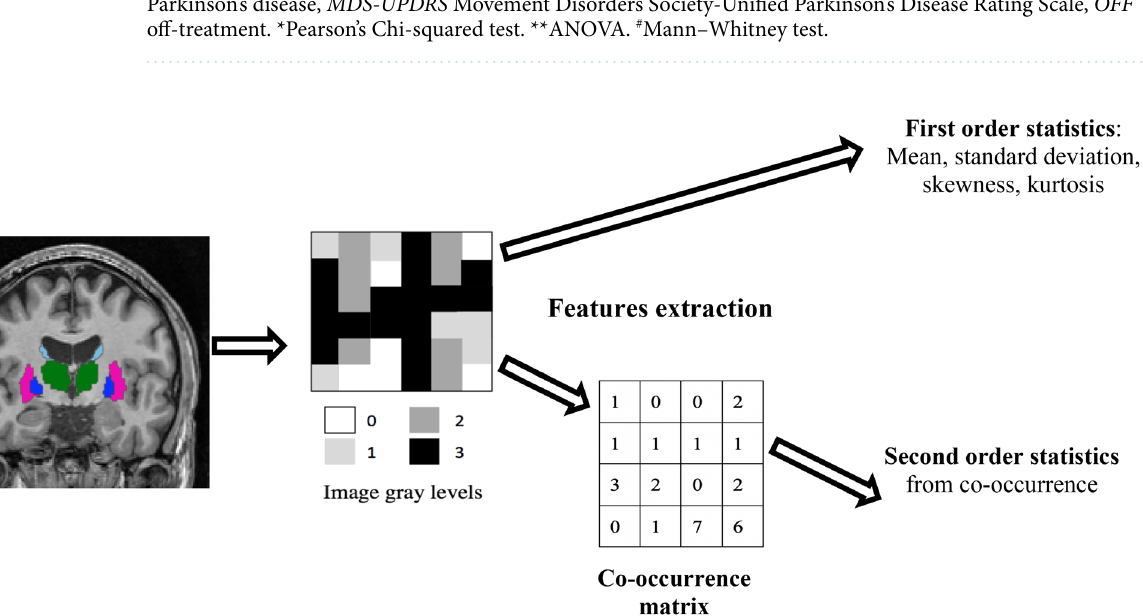
Table 3. Demographic and clinical characteristics of the three study populations. M male, F female, PD Parkinson’s disease, MDS-UPDRS Movement Disorders Society-Unified Parkinson’s Disease Rating Scale, OFF